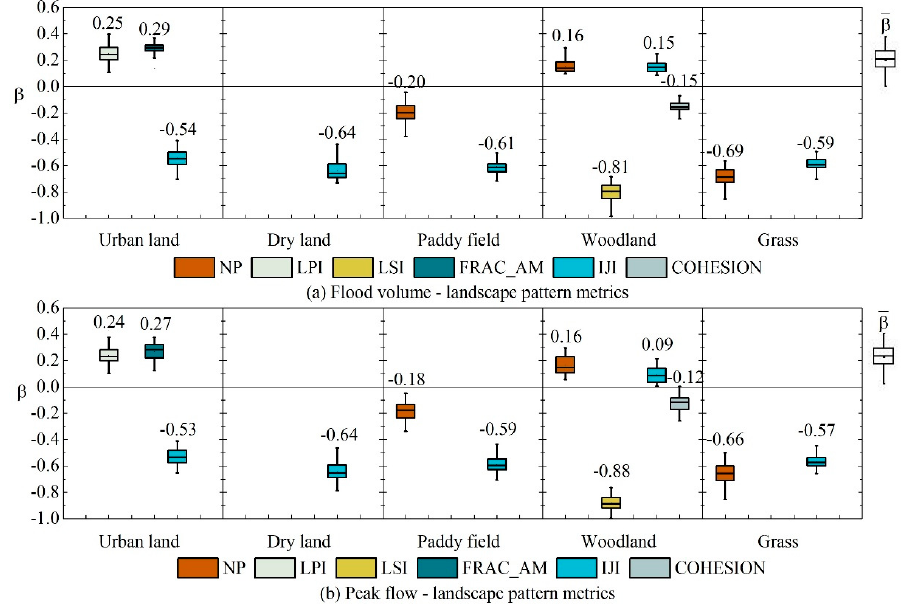
Figure 7. Box diagrams of regression analysis results.